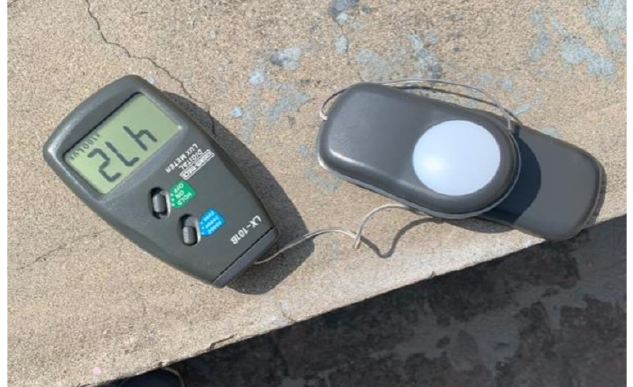
Figure 8. Observation for lumens using a lux meter For the sun, there is an approximate conversion of 0.0079W/m2 per Lux.